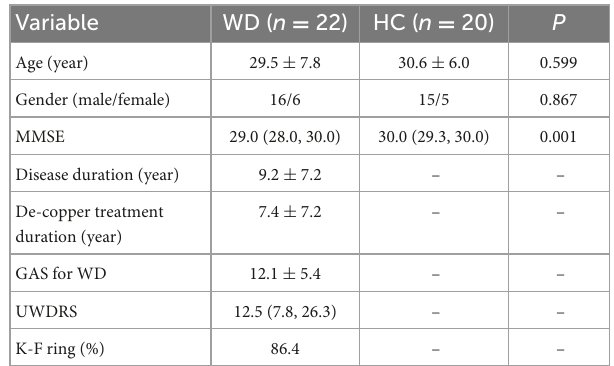
TABLE 1 Demographic and clinical characteristics of participants.